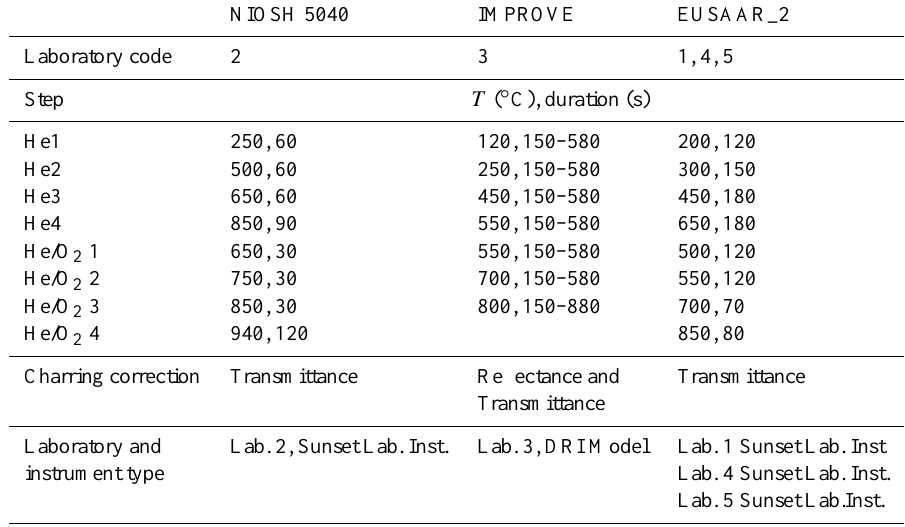
Table 1. Analytical protocols, type of charring correction and instrument used by each laboratory in the French intercomparison. NIOSH 5040